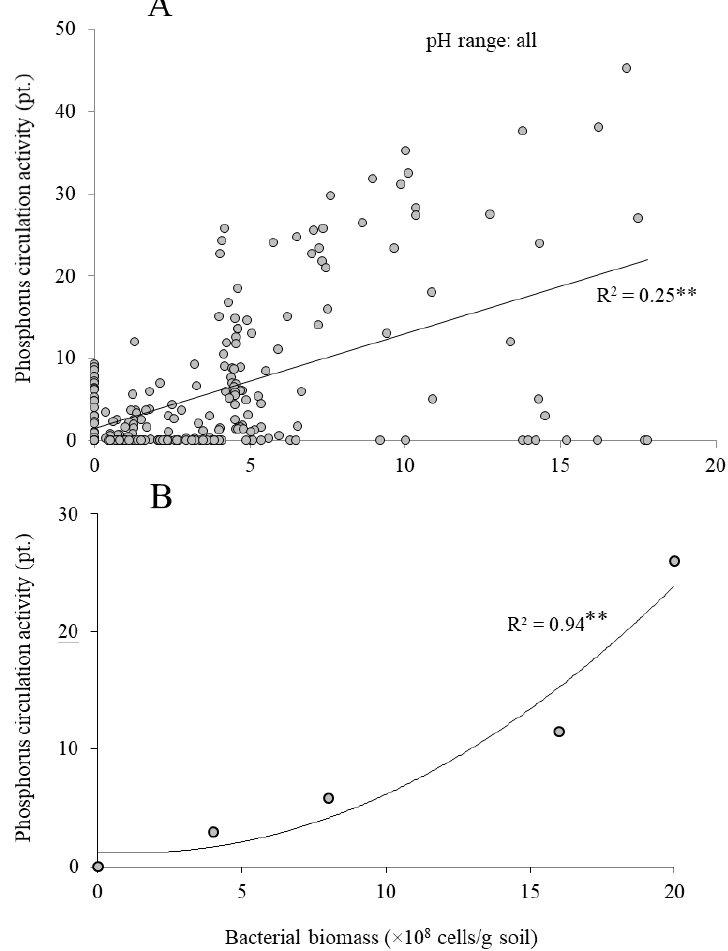
Figure 2. Relationship between phosphorus circulation activity and bacterial biomass in: ( A ) various agricultural soils ( n = 232) and ( B ) the same agricultural soil with different bacterial biomass. Soils in ( B ) were prepared by mixing autoclaved soil at different ratios. R 2 -value marked with two asterisks (**) indicates significant regression ( p < 0.01).